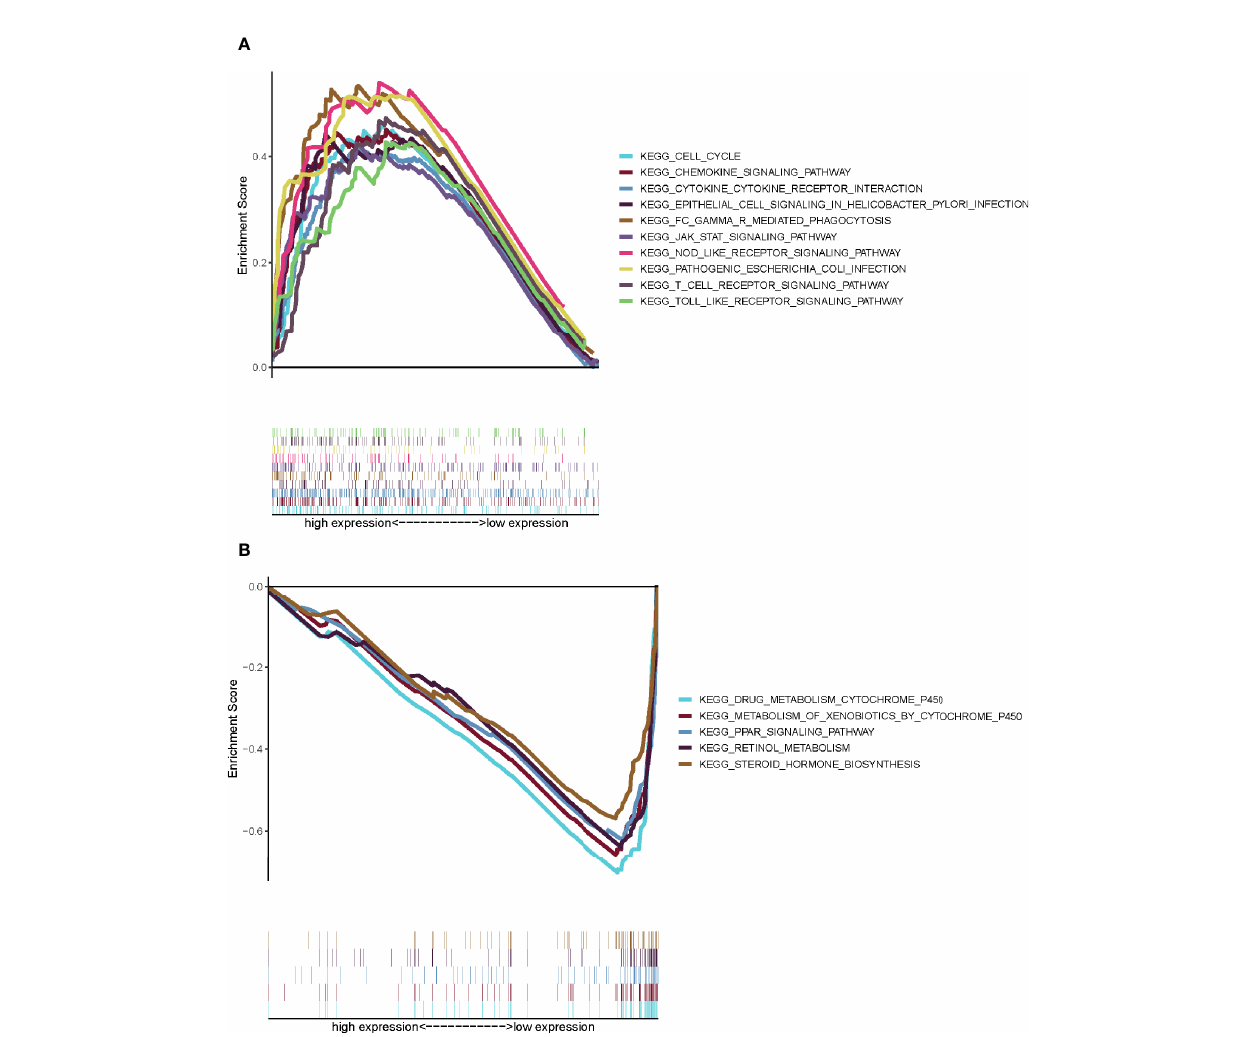
FIGURE 7 | GSEA for samples with high CXCL5 expression and low expression. (A) GSEA for samples with high CXCL5 expression; (B) GSEA for samples with low CXCL5